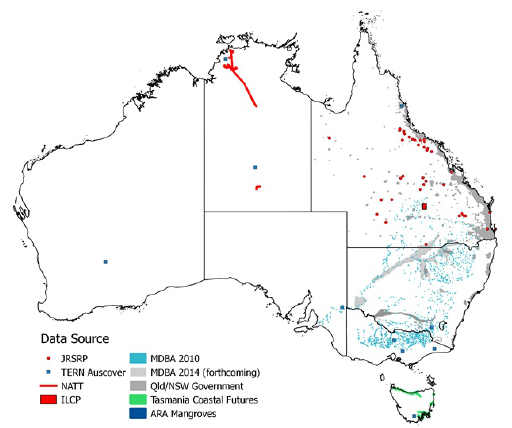
Figure 2. Location of airborne laser scanning (ALS) datasets acquired over Australia by TERN Auscover and collated by the Queensland, New South Wales, Northern Territory and Tasmanian State